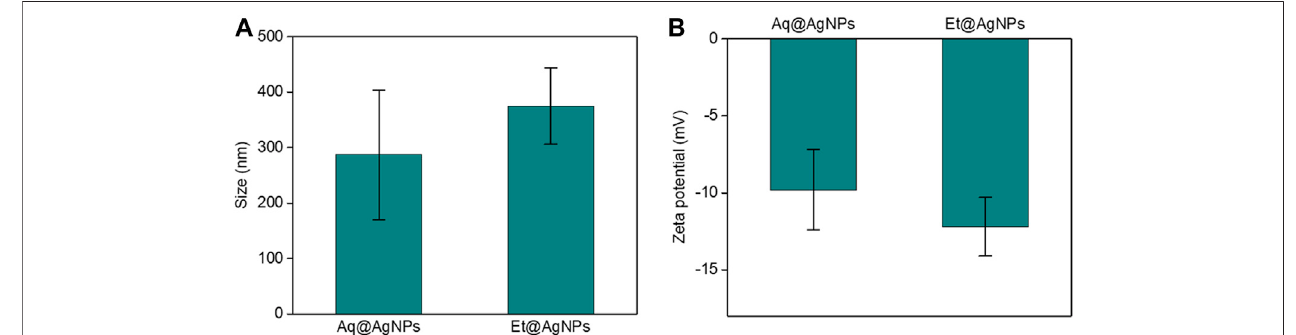
FIGURE 2 | Determination of (A) size and (B) surface potential of Aq@AgNPs and Et@AgNPs.